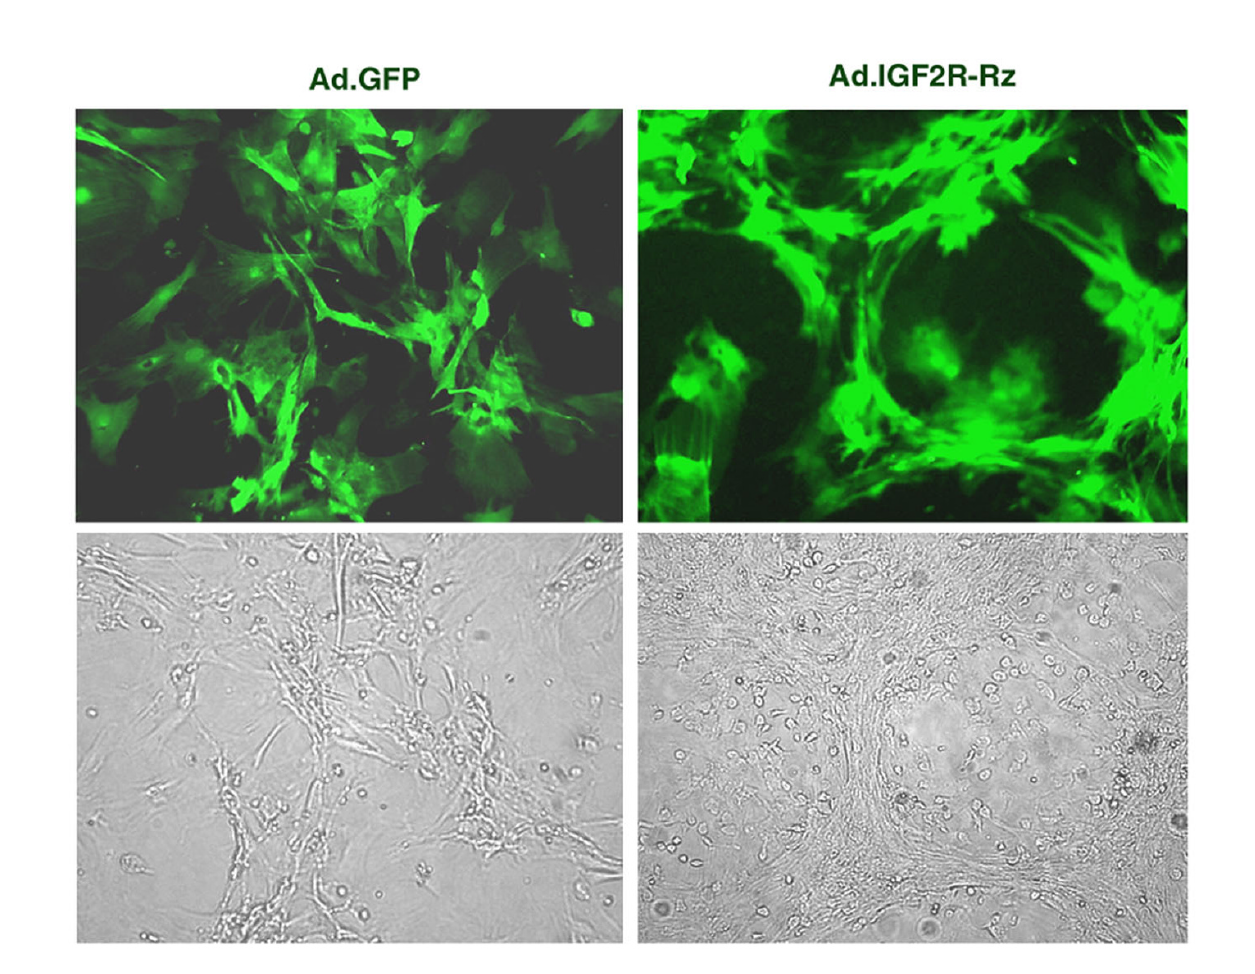
Figure 4 Microphotographs showing the effect of the ribozyme on the growth of neonatal rat cardiac myocytes. Cells were infected with Ad-GFP/IGF2R-Rz or Ad-GFP. The photographs were taken directly from the culture plate under 510 nm light (upper panels) and under bright light (lower panels) using a fluorescence